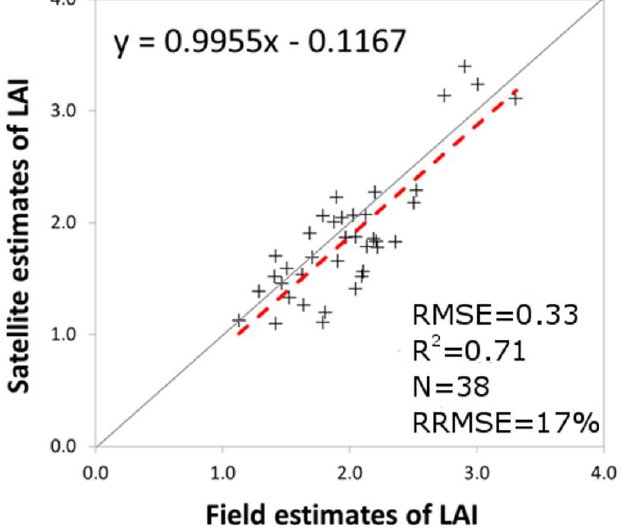
Figure 6. Scatter plots ( n = 38) of field LAI estimates (23 to 24 July 2014) and satellite estimates of LAI (RapidEye image, 2 August 2014). RMSE: root mean square error. R 2 = coefficient of determination. RRMSE: relative root mean square error. The broken red line shows the ordinary least squares linear regression fits. In black is the 1-to-1